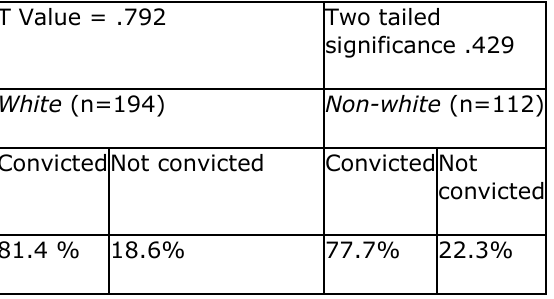
Figure 1: Percentage of Convictions by Type of Offense,